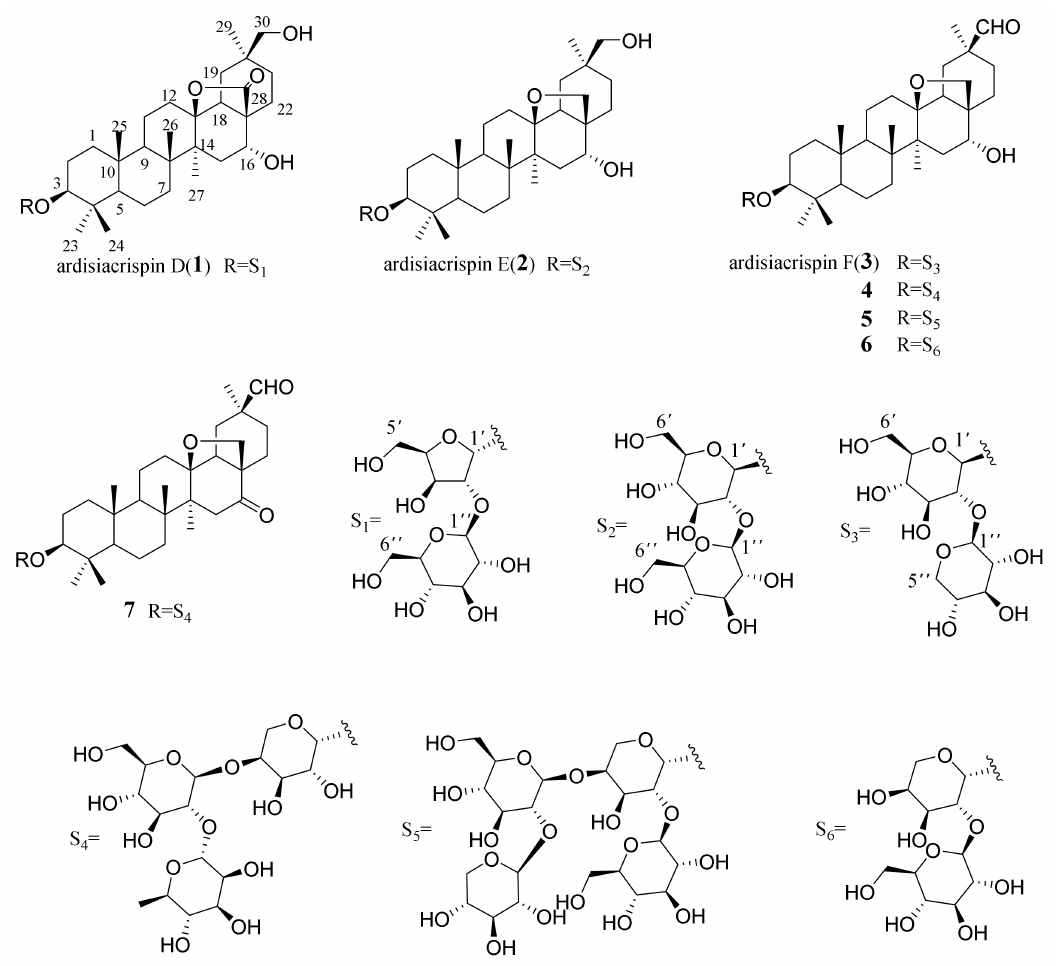
Figure 3. Chemical structures of compounds 1 –